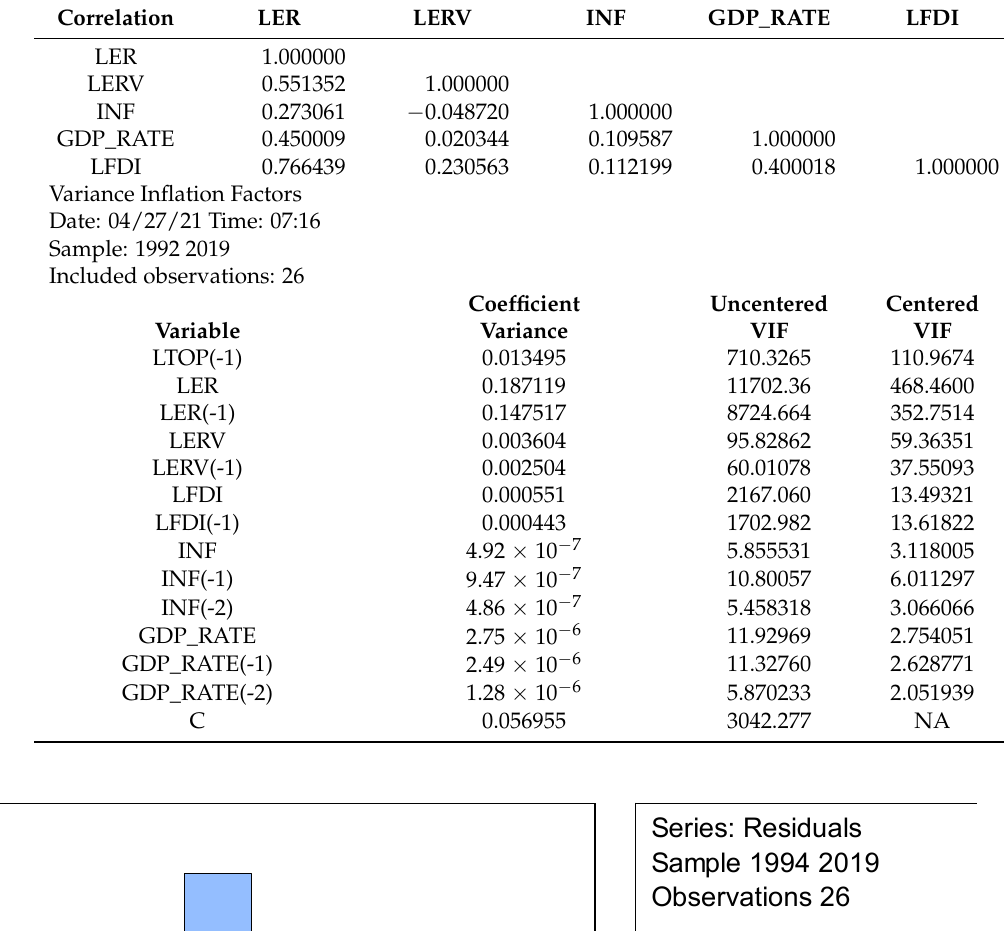
Table A1. Multicollinearity test result.